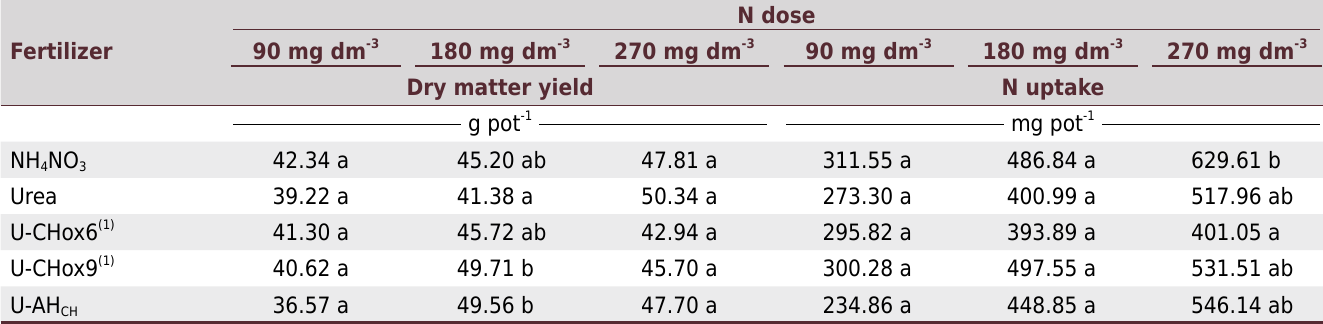
Table 8. Dry matter yield and N uptake by corn plants for each N dosage applied as NH 4 NO 3 , urea, and urea mixed with functionalized charcoals (U-CHox6 or U-CHox9) or humic acids derived from CHox (U-AH CH )